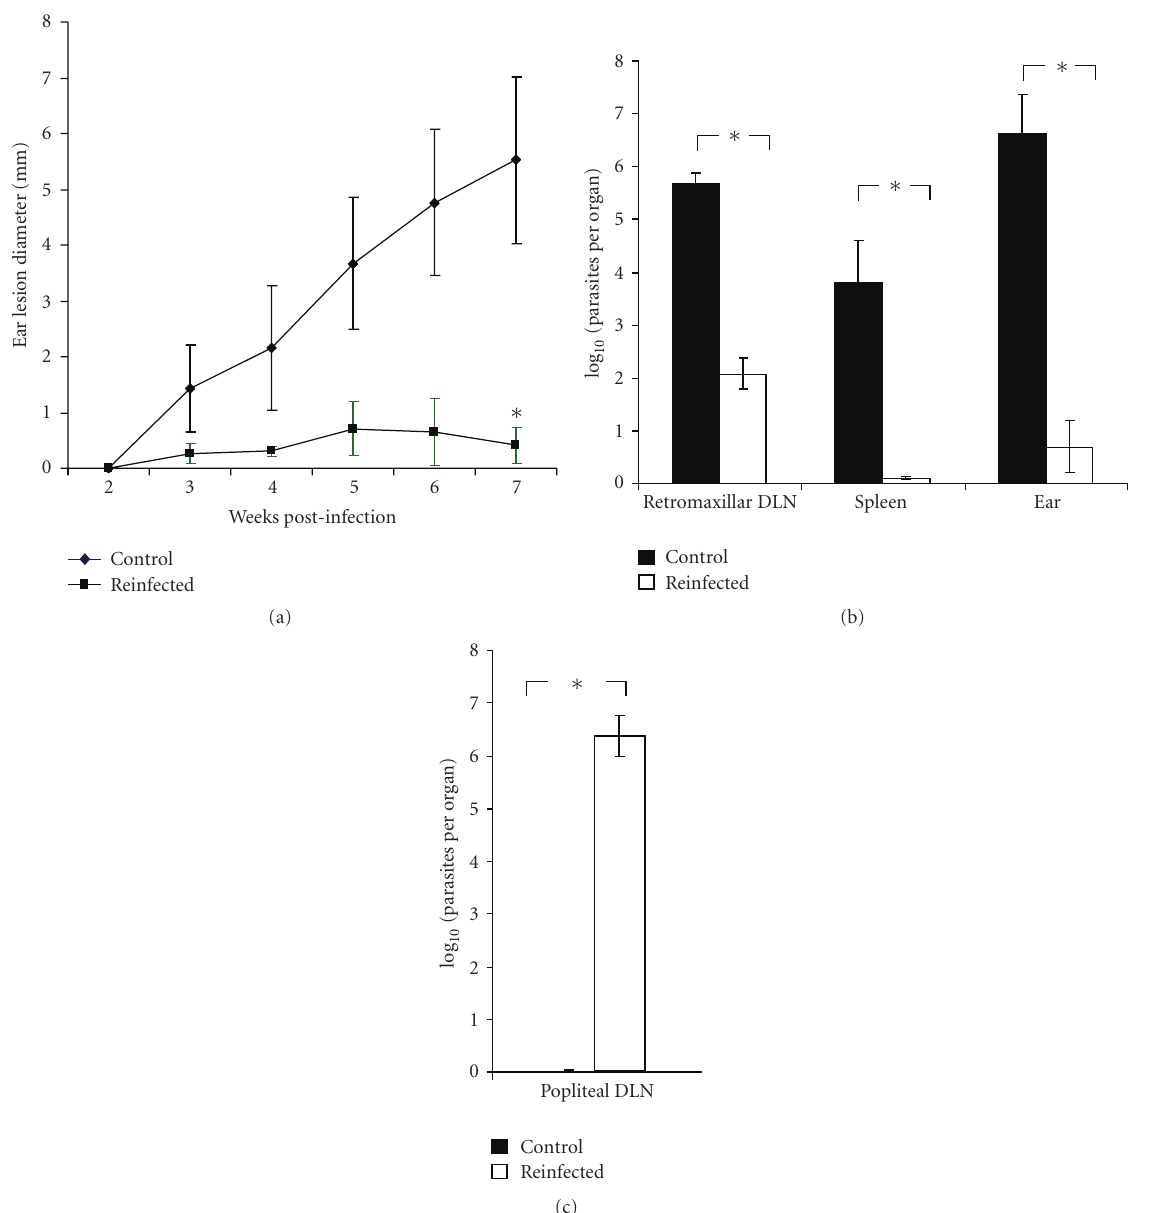
Figure 2: (a) Course of L. major infection in protected and reinfected BALB/c mice. Values represent the mean lesion diameter ± standard deviation (SD). ∗ P < . 001: significant di ff erences in inflammation for protected versus control mice at week seven postchallenge. (b) Seven weeks after reinfection, mice were euthanized and parasite burden in the ear dermis, spleen and in the retromaxillar DLN was individually quantitated. Results are expressed as the mean ± SD of twelve ears and six spleens and DLN. ∗ P < . 001: significant decrease for reinfected versus control mice. (c) The parasite burden at week seven after rechallenge was individually quantitated in the popliteal lymph nodes of control and reinfected mice. Results are expressed as the mean ± SD of six DLN. ∗ P < . 001: significant decrease for reinfected versus control